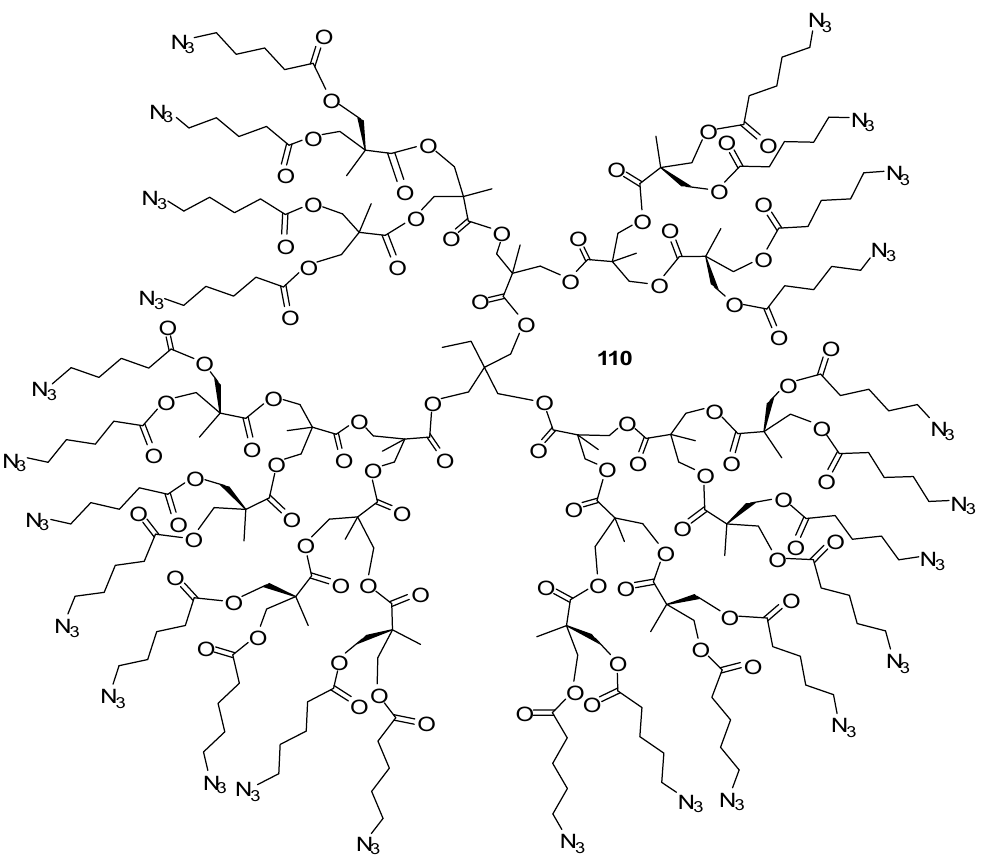
Figure 8. Azide-terminated third generation dendrimer